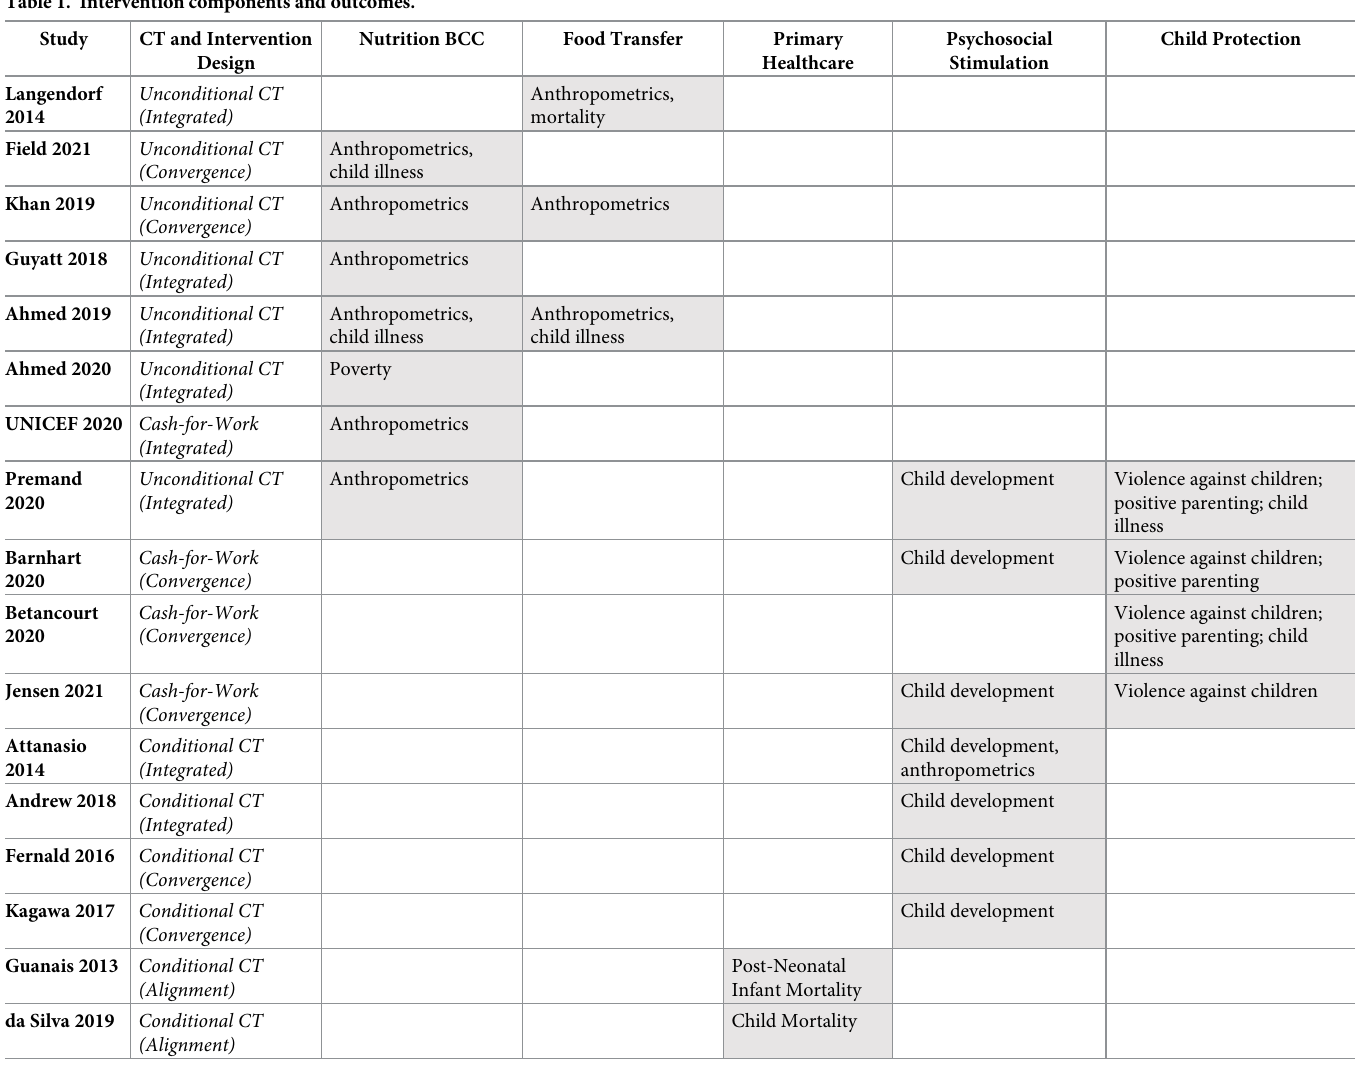
Table 1. Intervention components and